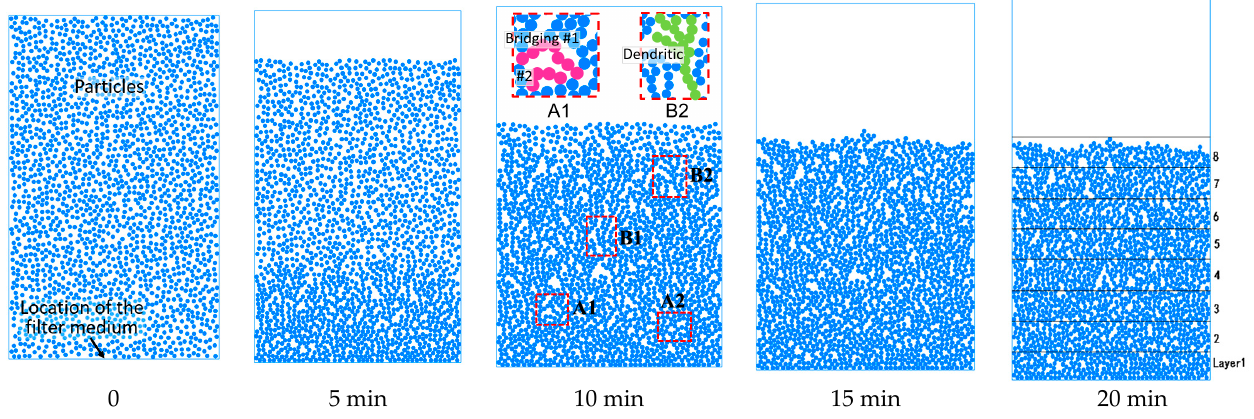
Figure 1. The deposition process of particles on the surface of the filter medium.